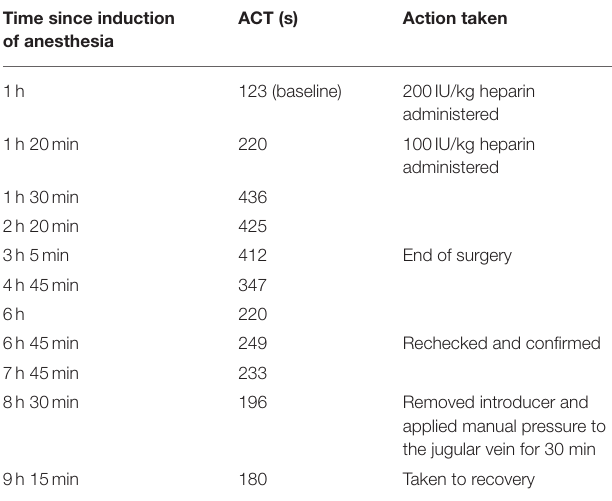
TABLE 1 | ACT measurements recorded for a Yucatan mini-pig during venous stent implantation that later died following ovarian hemorrhage associated with anticoagulation